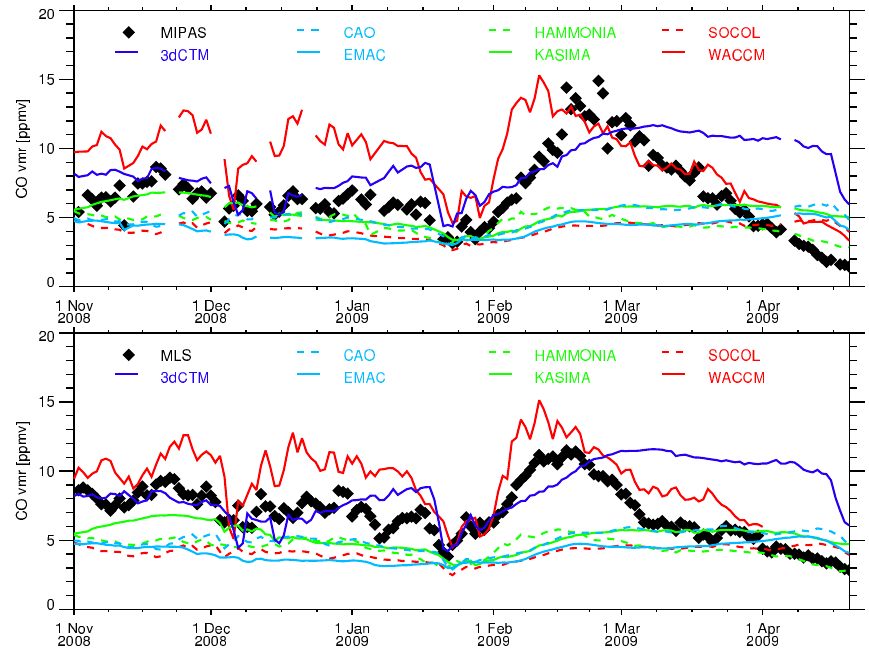
Figure 10. MIPAS-NOM (top) and MLS/Aura (bottom) temporal evolutions of CO VMR in comparison with the model results within 70–90 ◦ N at